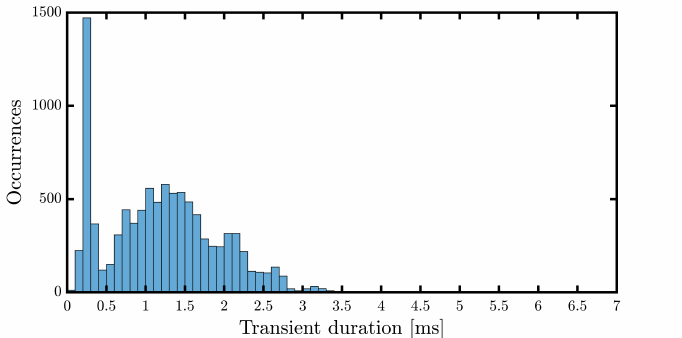
Figure 3. Histogram of the transient amplitudes in the 9768 database segments. Notice that the original transient detection used to build the database ignored events with transient amplitudes below 0.1 pu, and, therefore, there are no events below that amplitude.